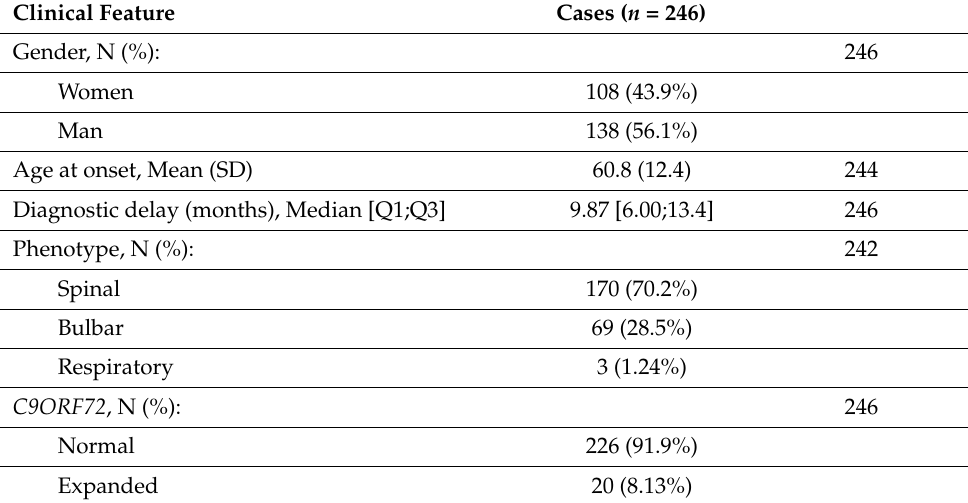
Table 1. Clinical features of ALS